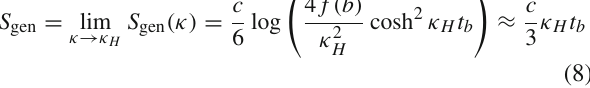
of R + and R − are indicated as b + and b − , respectively. The island extends between the two wedges and its boundaries are at a + and a − . Inthe Reissner–Nordström blackhole, the curvature is singularat r = 0 whereas it is finite there in the Hayward black